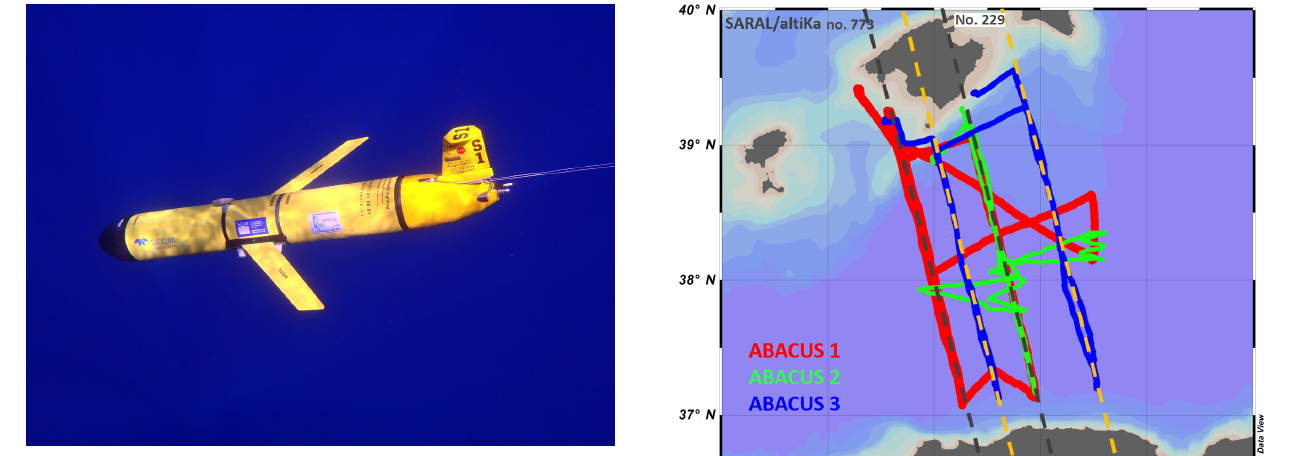
Figure 1. The SLOCUM G2 glider during the ABACUS pre- mission test at sea. Credit M. Torner.